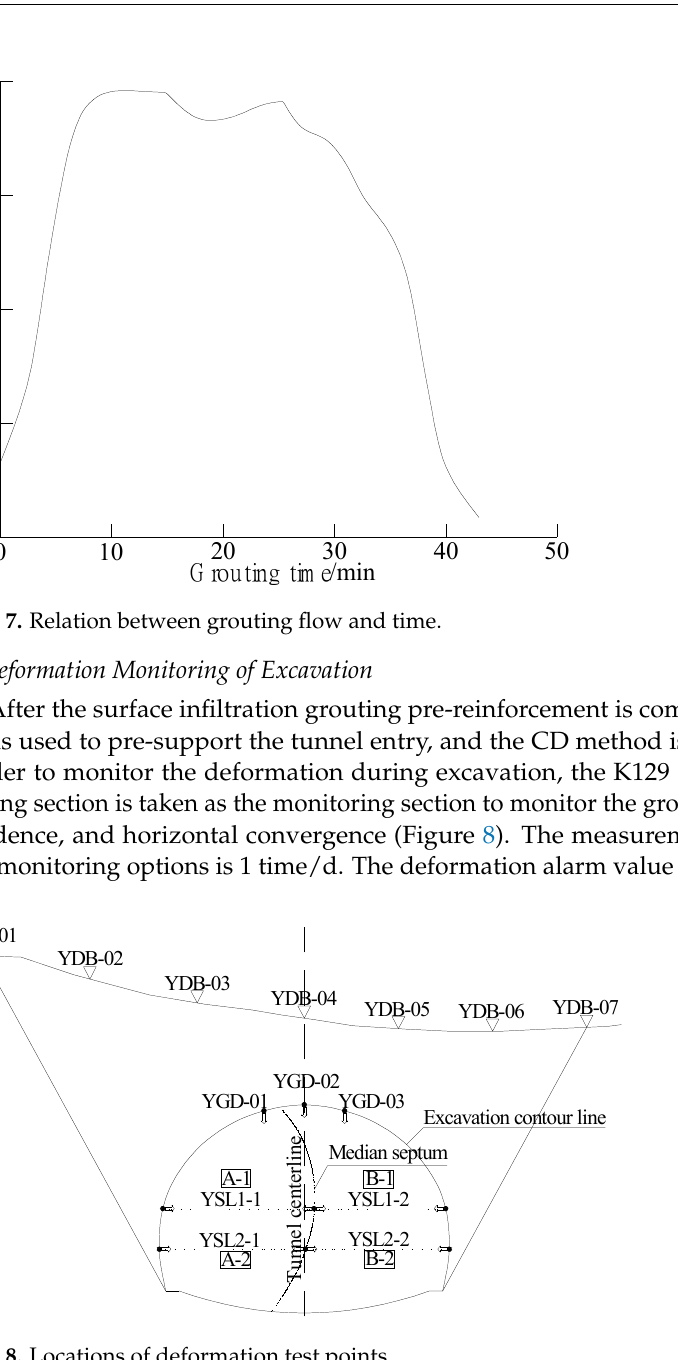
Figure 6. Relation between grouting pressure and time.